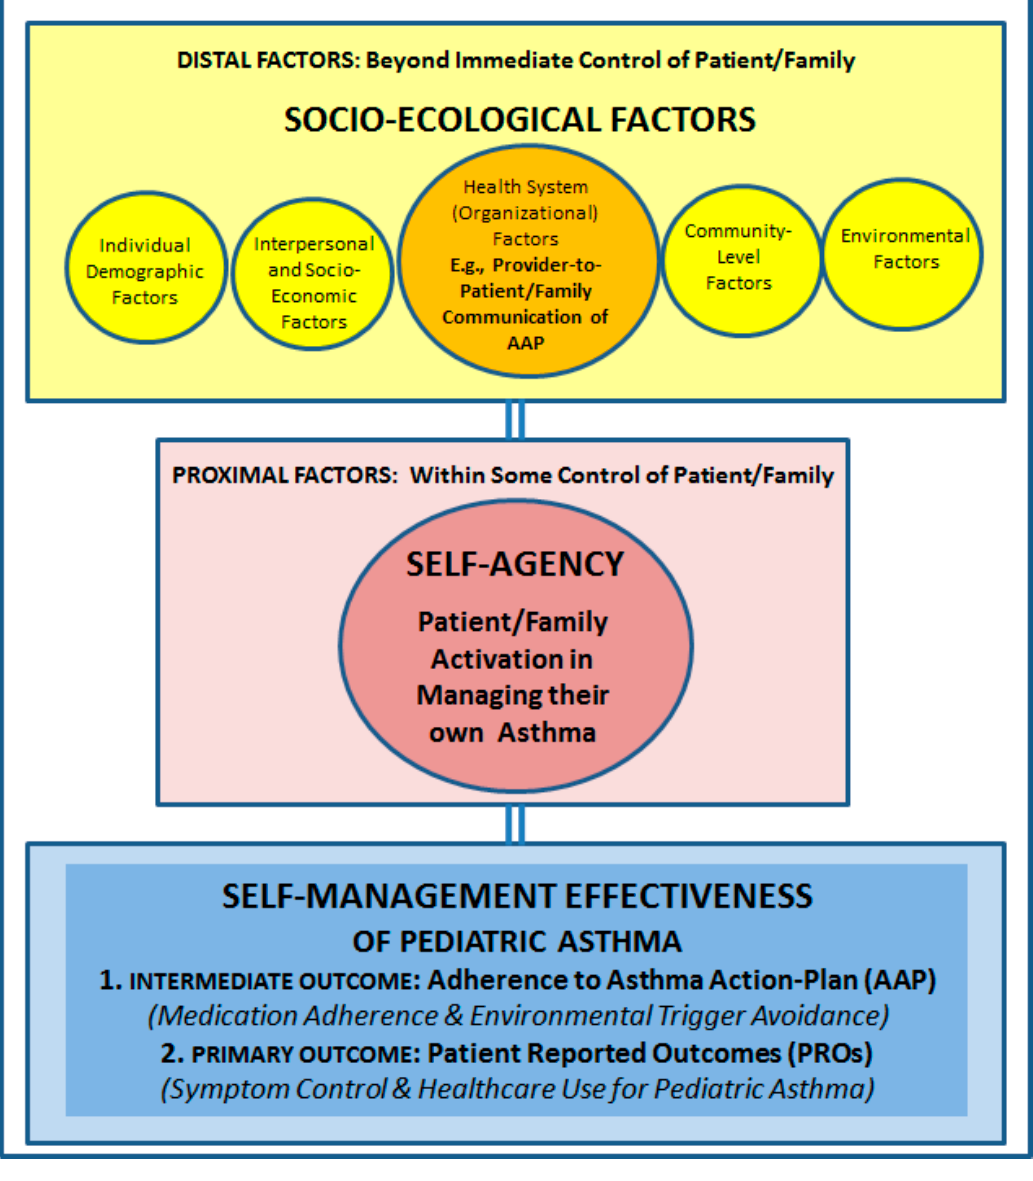
Figure 1. A Holistic Framework for Assessing Self-Management Effectiveness of Pediatric Asthma.